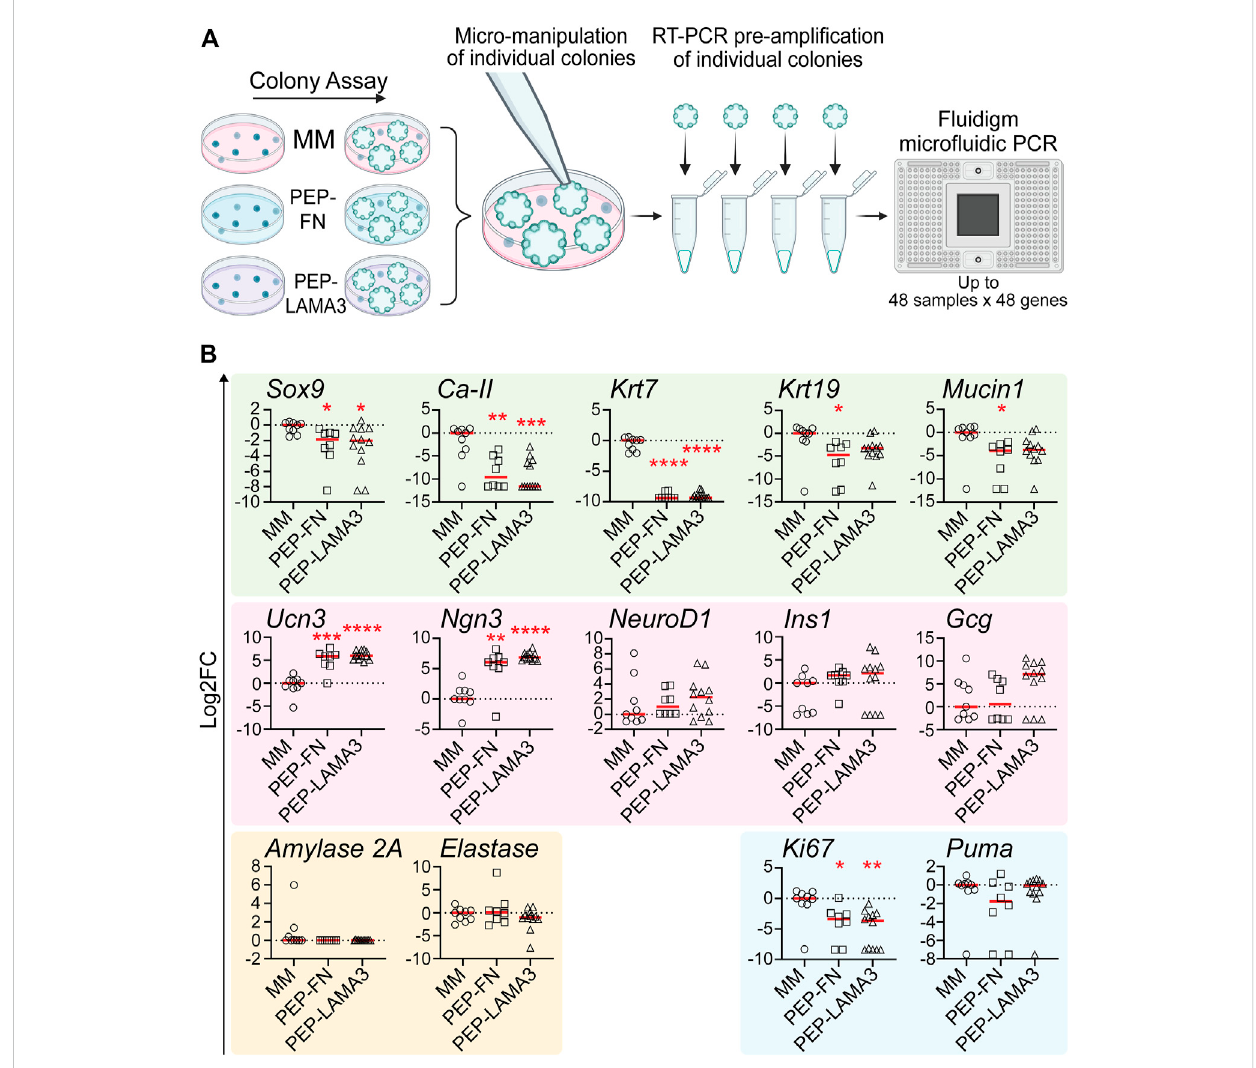
FIGURE 3 PEP-FN and PEP-LAMA3, compared to Matrigel-methylcellulose medium, support pancreatic cells that express higher levels of endocrine and endocrine progenitor cell markers, and lower levels of ductal cell markers. (A) Experimental scheme. Pancreases from 8-day-old mice were dissociated intoasinglecellsuspensionandplatedintocolonyassayscontainingMatrigel-methylcellulose(MM),PEP-FNorPEP-LAMA3.Theresultingcolonieswere visualized under a light microscope and individually lifted one-by-one. mRNA from each colony was converted into cDNA in a single-step RT-PCR reaction. Pre-ampli fi ed cDNA was run in a micro fl uidic PCR chip, where multiple genes expressed by a colony were detected simultaneously (B) Gene expression analysis using micro fl uidic qRT-PCR on individual colonies grown indifferent cultures. Data were fi rst analyzed relative to the internal control housekeeping gene, B2M. Subsequently, thedata were transformed into Log 2 scale and normalized to the median of the expressionlevels from colonies grown in thecontrol MM medium. Student ’ st-testwith Welch ’ scorrection wasused to determinethesigni fi cance of thevalues betweenPEP-FN vs.MM and PEP-LAMA3 vs. MM media. Data were derived from a total of 8 – 12 colonies grown in various media. Each dot represents a colony and the red